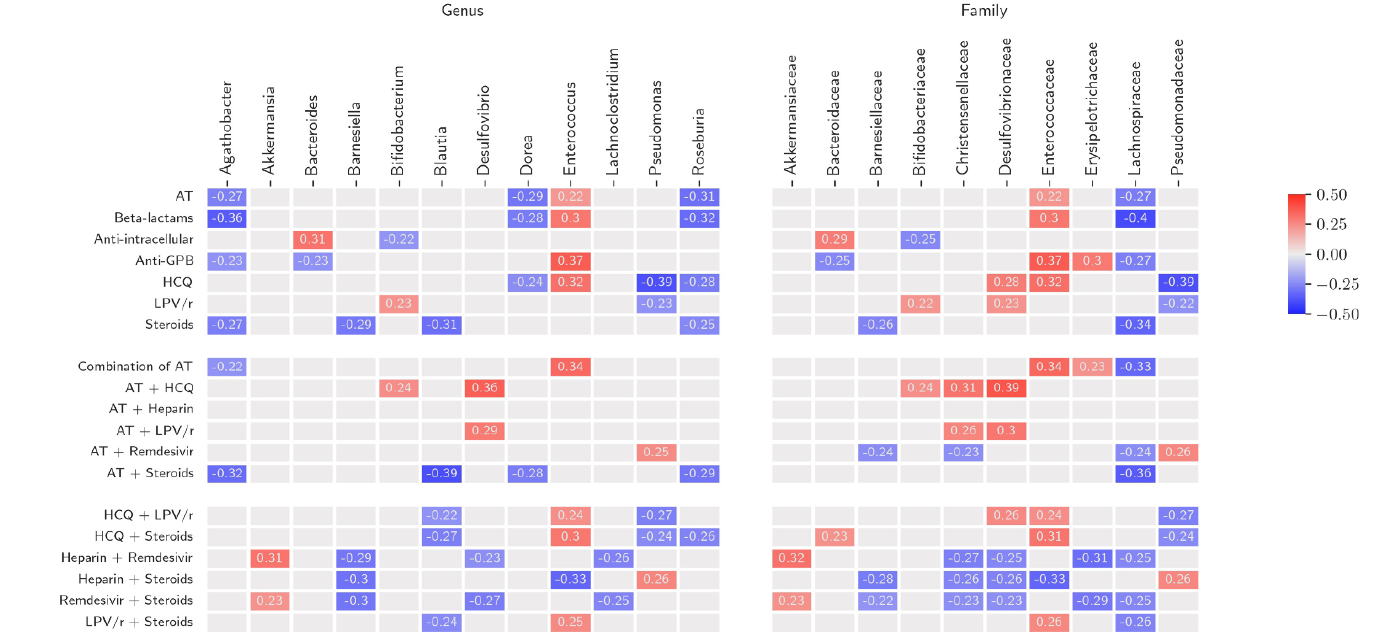
Figure 5. Spearman plot showing the correlation between the gut microbiome composition and treatment duration at the genus and family levels. Lachospiraceae and Barnesiellaceae at family level and symbionts such as Agathobacter , Dorea , and Roseburia at genus level showed negative correlations with COVID-19 and antibiotic treatment. Enterococcus showed positive correlations with antibiotic treatment (in particular with beta-lactams and anti-GPB) and HCQ with or without LPV/r and negative correlation only with steroids and heparin that is currently the most commonly used treatment for COVID-19 in hospitalized patients. Families and genera of the bacteria are reported in alphabetical order. Treatment data are shown according to number of days receiving COVID-19 treatment (HCQ, LPV/r, remdesivir, heparin, and steroids) or antibiotic class (beta-lactam, intracellular, or anti-GPB antibiotics) and to the use as a single agent or in combination at the time of sample collection. AT = any antibiotic; GPB = Gram positive bacteria; HCQ = hydroxychloroquine; LPV/r = lopinavir/ritonavir. Beta-lactams included amoxicillin/clavulanate, piperacillin/tazobactam, ceftri- axone, meropenem; intracellular antibiotics included ciprofloxacin, clarithromycin, azithromycin, doxycycline; anti-GPB antibiotics included vancomycin, daptomycin, and linezolid. The strength of the Rho coefficient is represented by the change in the square colour intensity.